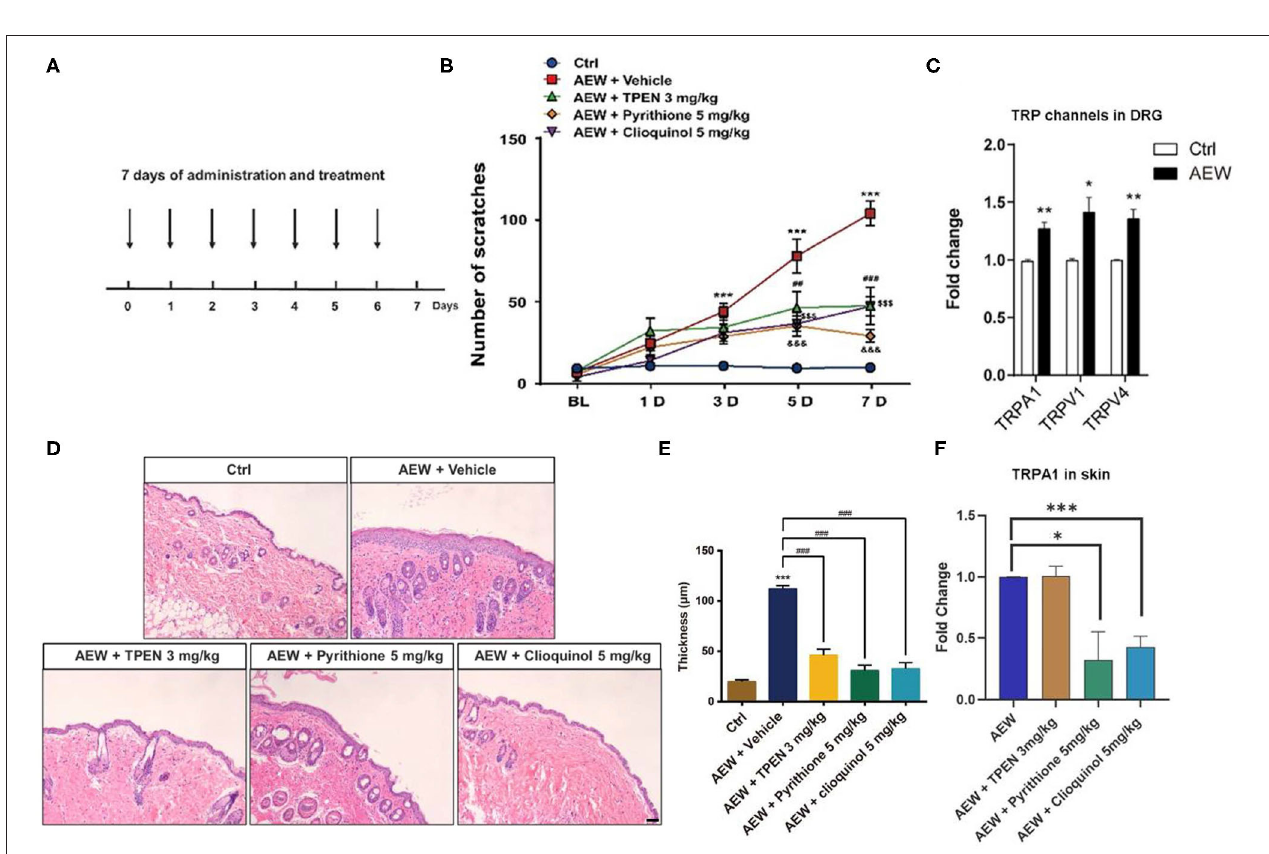
FIGURE 6 | The effects of the administration of three Zn 2 + chelating agents on dry skin chronic model. (A) The establishment of dry skin-induced chronic itch model. (B) The three Zn 2 + chelators, such as TPEN (3 mg/kg), pyrithione (5 mg/kg), and clioquinol (5 mg/kg) can significantly inhibit the chronic itching behavioral response of mice induced by dry skin (*** P < 0.001 vs. Ctrl, ## P < 0.01, ### P < 0.001, $$$ P < 0.001, &&& P < 0.001 vs. AEW + Vehicle, two-way ANOVA following post-hoc Bonferroni’s test; n = 6–10 per group). (C) The mRNA expression levels of Trpa1 , Trpv1, and Trpv4 in the DRG of dry skin induced chronic itch model (* P < 0.05, ** P < 0.01 vs. Ctrl, unpaired Student’s t -test; n = 5 per group). (D) The effects of treatment with Zn 2 + chelators on the epidermal thickness of the dry skin induced chronic itch model. (* P < 0.05, ** P < 0.01, *** P < 0.001 vs. Ctrl, unpaired Student’s t- test; n = 5 per group). (E) The epidermal thickness statistics of the dry skin model group and the treatment group (*** P < 0.001 vs. Ctrl, ### P < 0.001 vs. AEW + Vehicle, unpaired Student’s t -test; n = 4 per group). (F) Zn 2 + chelators pyrithione (5 mg/kg) and clioquinol (5 mg/kg) can decrease Trpa1 mRNA level, but not for TPEN (3 mg/kg) (* P < 0.05, *** P < 0.001 vs. AEW, unpaired Student’s t -test; n = 5 per group). All data are expressed by means ± SEM. Ctrl, control; n.s., not